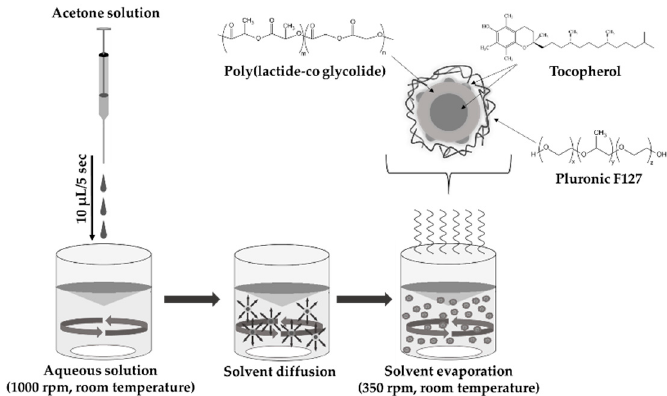
Figure 1. Schematic representation of the preparation of TP-loaded PLGA NPs stabilized by PLUR using nanoprecipitation technique. Table 1. The concentration of the components, the average particle diameter, the polydispersity index (PI), the encapsulation efficiency (EE%) and the drug loading (DL%) of the TP-loaded PLA NPs.